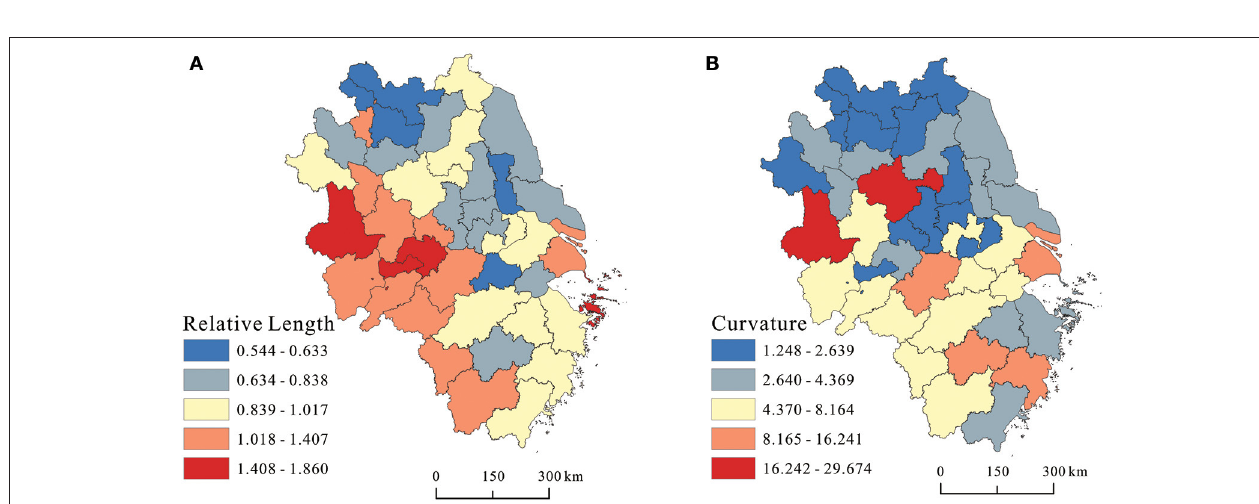
FIGURE 4 | Local spatial association pattern of healthcare service supply in (A) 2007, (B) 2013, and (C) 2019.